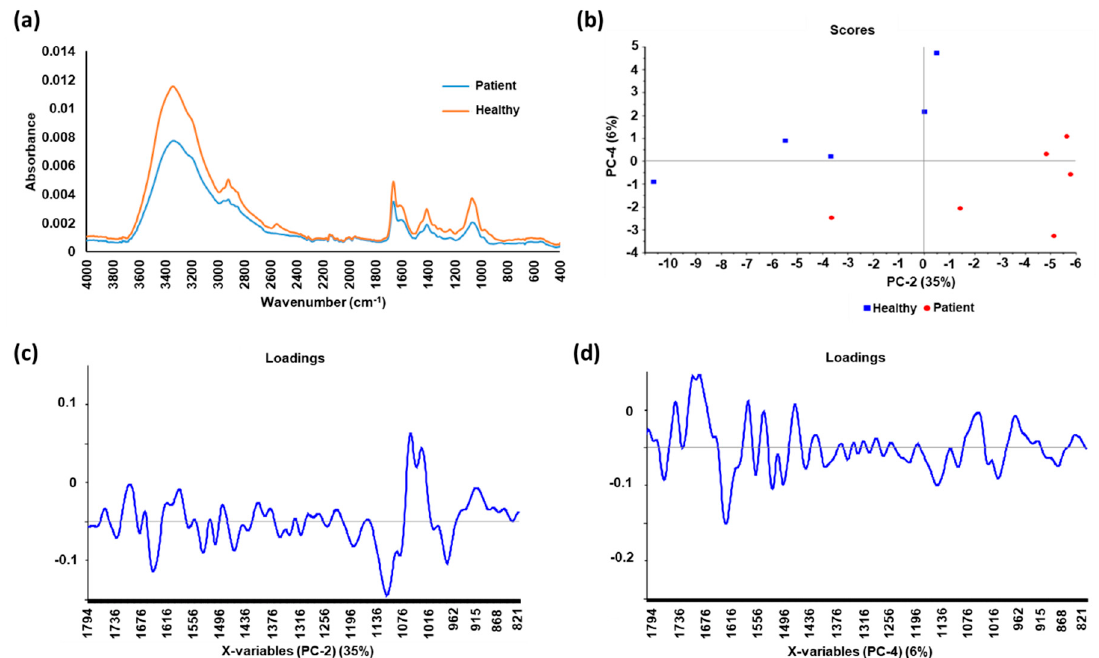
Figure 1. The average spectra and principal component analysis (PCA) of urinary extracellular vesicle (EV) samples from prostate cancer patients and healthy individuals ( a ) The average spectra of the EV samples from patients has a lower absorbance compared to that from healthy individuals; ( b ) Score plot of second and fourth PCs, with corresponding percentage of explained variance in parentheses; ( c ) Loadings of the second PC with 35% of explained variance; ( d ) Loadings of the fourth PC with 6% of explained variance. Spectral peak differences between the two groups were revealed after analyzing the spectra with PCA, suggesting possible biomarkers for prostate cancer. Linear discriminant analysis (LDA) was used to derive a diagnostic classifier for prostate cancer from the spectra, which achieved sensitivity of 83.33% and specificity of 60%.